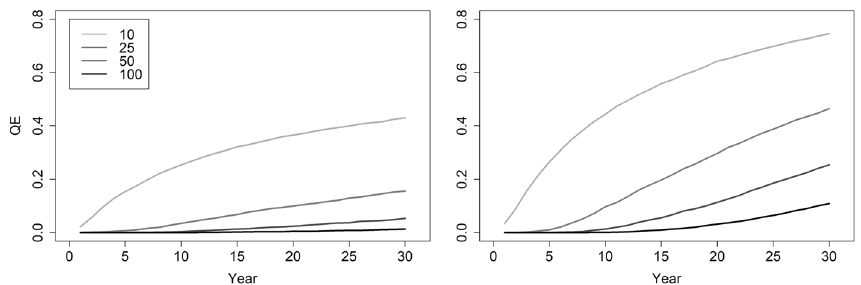
Figure 2. Plots portraying the probability of quasi-extinction ( QE ; mean abundance ≤ 5 adult females) of adult females based on 10,000 stochastic simulations of population trajectories. The left panel locks recruitment to 0.30 and survivorship at 0.90 (stochastic λ ~ 1.0) and the right panel has recruitment and survivorship at 0.30 and 0.85 respectively (stochastic λ ~ 0.97). Inset values indicate the starting abundances of adult females.